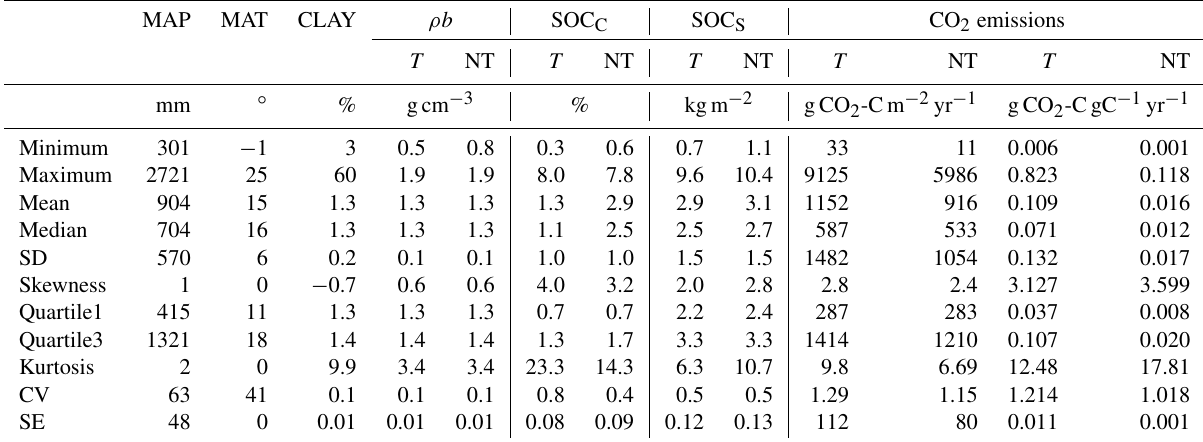
Figure 1. Percent change in (a) soil CO 2 emissions and (b) SOC in tillage ( T ) soil compared to no-tillage (NT) as a function of climate (arid and humid). The numbers in the parentheses indicate the direct comparisons of the meta-analysis. Error bars are 95% confidence intervals. Table 3. Summary statistics of mean annual precipitation (MAP), mean annual temperature (MAT), clay, soil bulk density ( ρb ), soil organic carbon content (SOC C ) , soil organic carbon stocks (SOC S ) , and CO 2 emissions (gCO 2 -Cm − 2 yr − 1 and gCO 2 -CgC − 1 yr − 1 ) under tilled ( T ) and untilled (NT) soils.